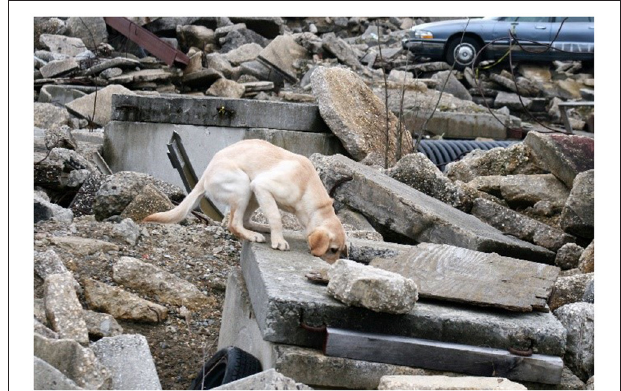
FIGURE 7 | Dog searching on rubble